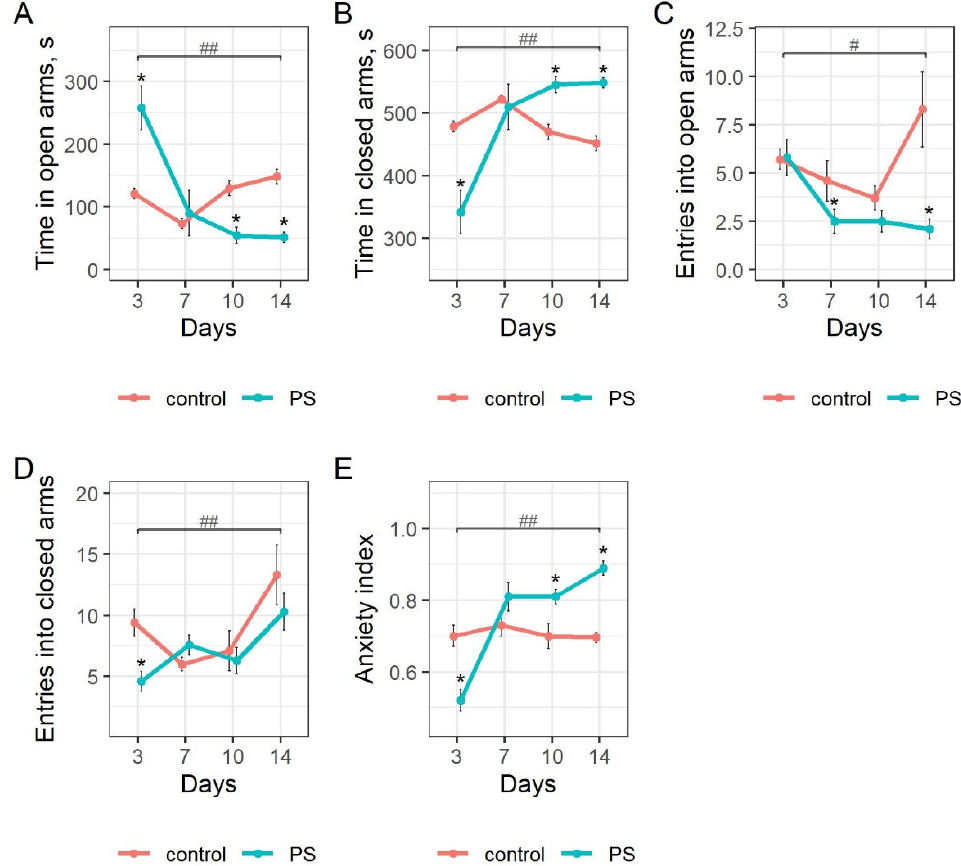
Figure 2. The impact of post-stress time on the behavioral patterns of stressed and control rats in the EPM test. Mann–Whitney comparisons for M ± SD of ( A ) time in open arms, ( B ) time in closed arms, ( C ) entries into open arms, ( D ) entries in closed arms, ( E ) anxiety index. * p < 0.05 for differences between means of respective control and PS groups. # p < 0.05, ## p < 0.01 for differences between means of PS group at post-stress days 3 and 14.